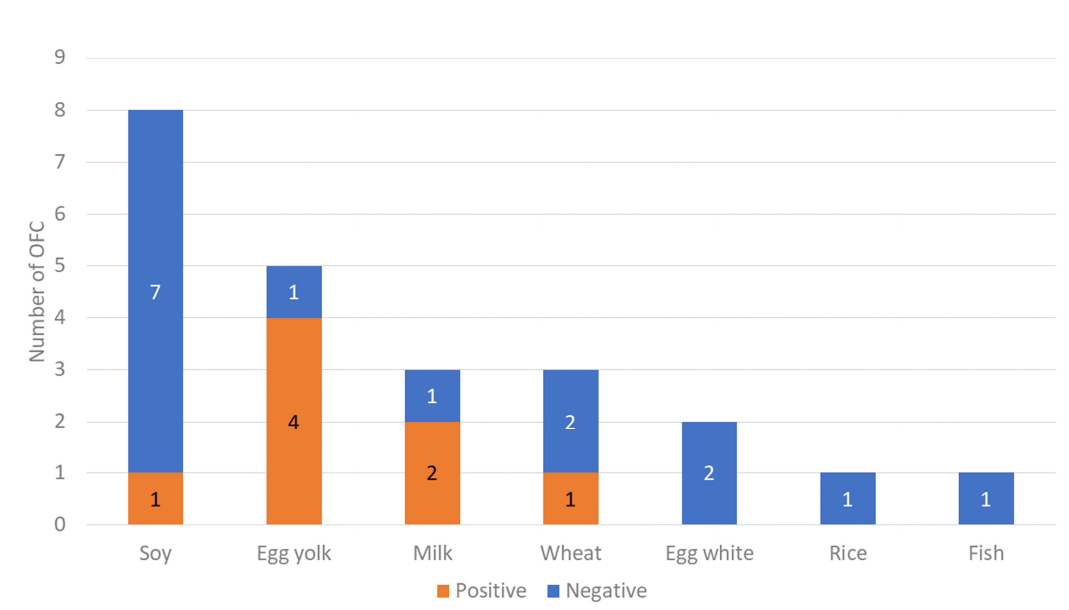
Figure 3. OFC outcomes for acute FPIES by causative food.